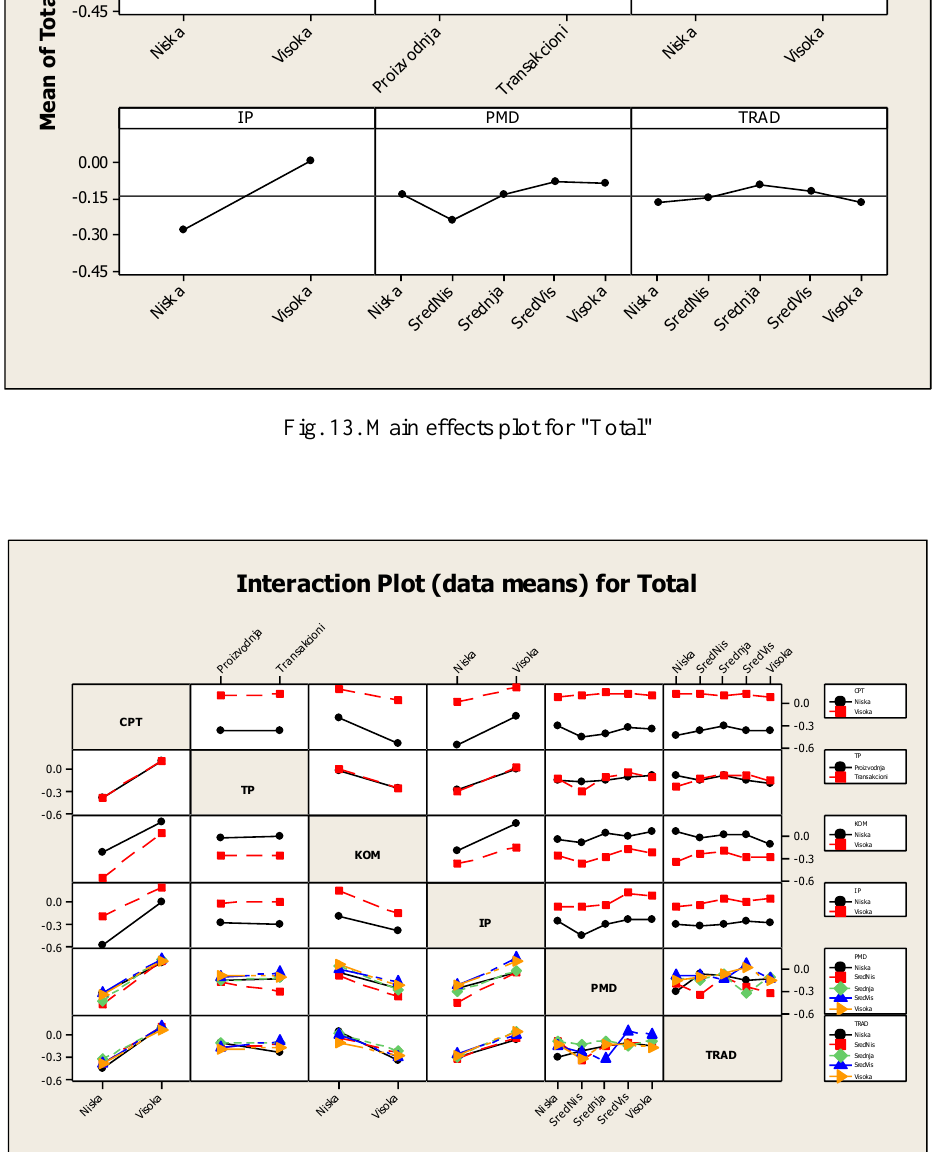
Fig. 14. Interaction plot for